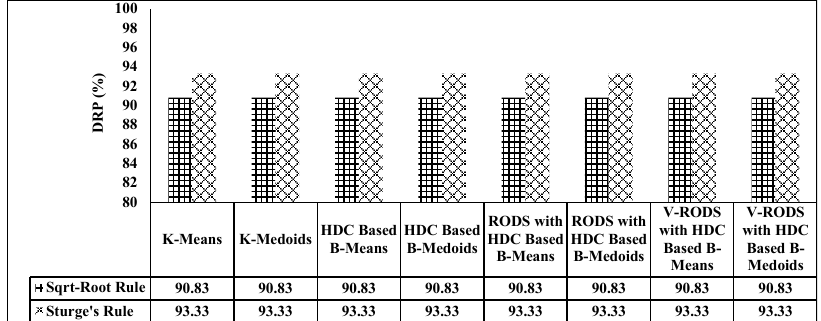
Figure 8. Performance of all evaluated techniques in DRP using two different rules when the K values are set to 11 and 8